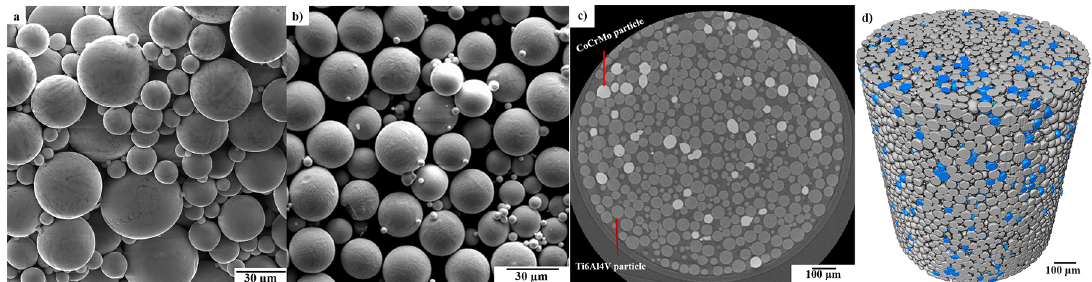
Figure 1. SEM micrographs of the initial powders: a) Ti6Al4V and b) CoCrMo and tomographic images: c) 2D virtual slice and d) 3D rendering of the powder